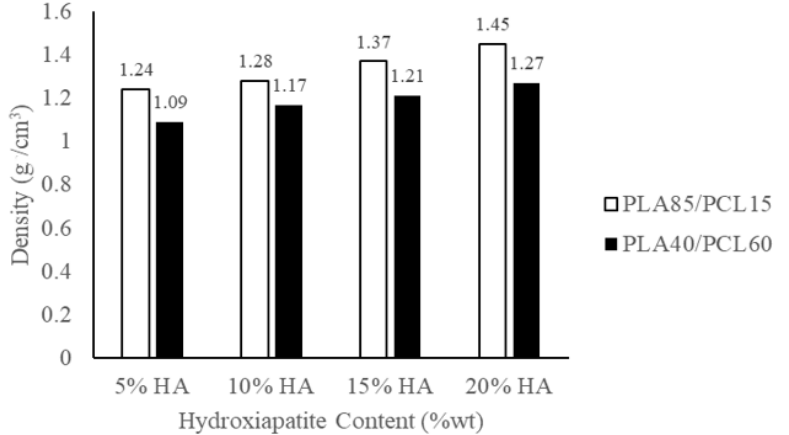
Figure 7. The density of the PLA/PCL/HA biocomposites.